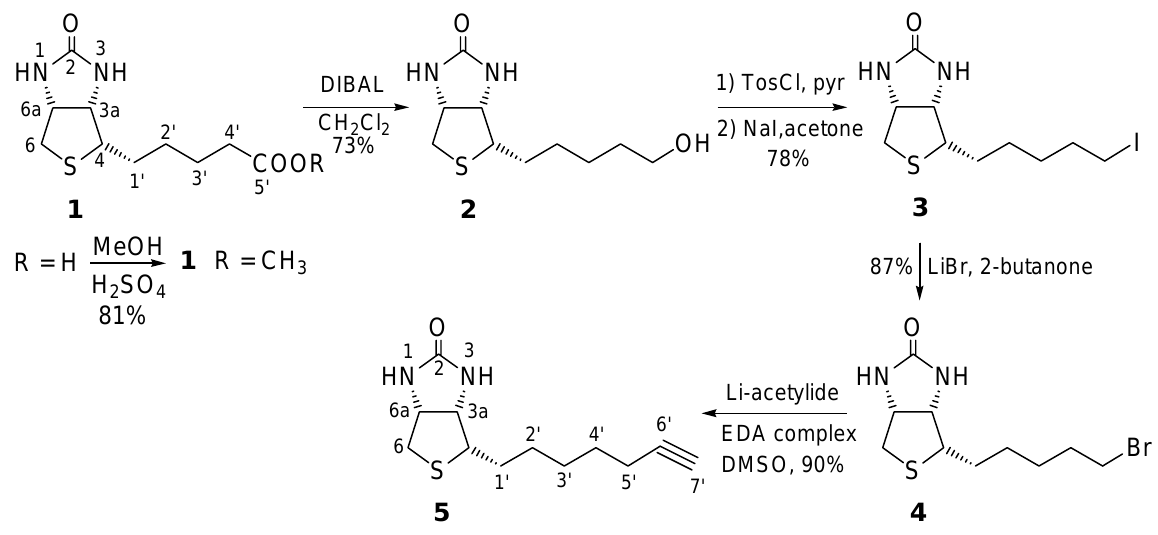
Figure 2. The 4 S -substituted (3a R ,6a S )-tetrahydro-1 H -thieno[3,4- d ]imidazol-2(3 H )-ones 1 – 5 .